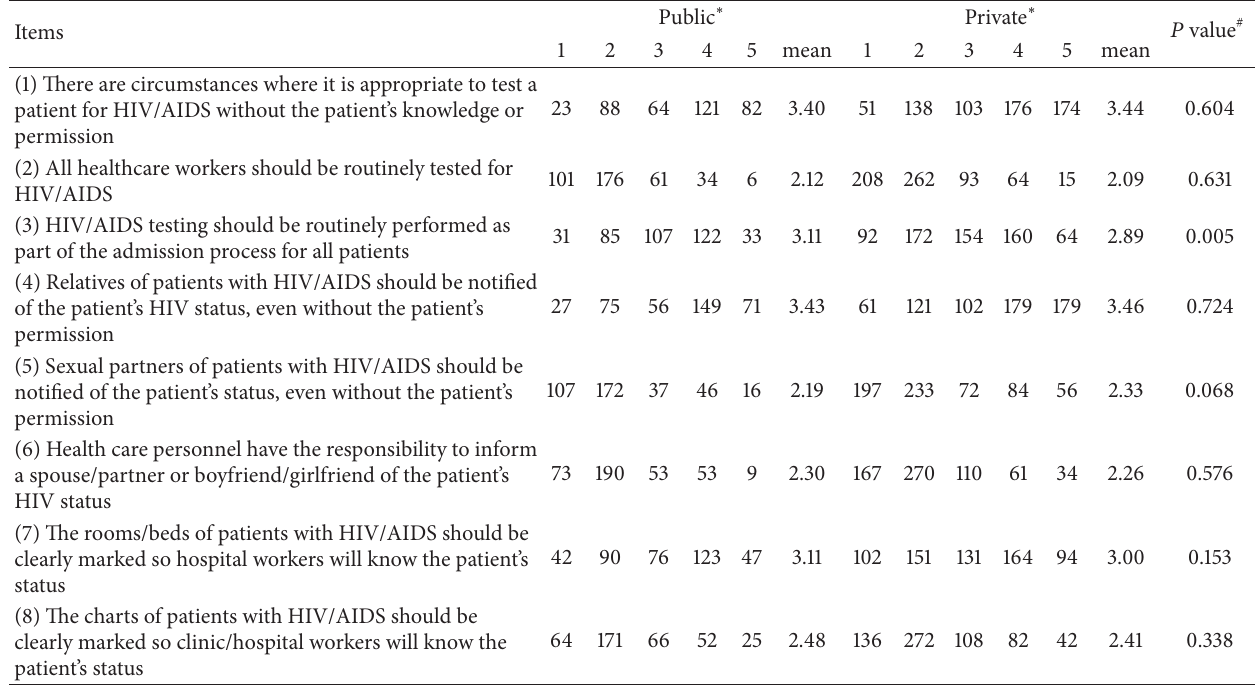
Table 3: Public and private medical students’ beliefs regarding testing, confidentiality, disclosure, and environment of care towards PLHWA. Items